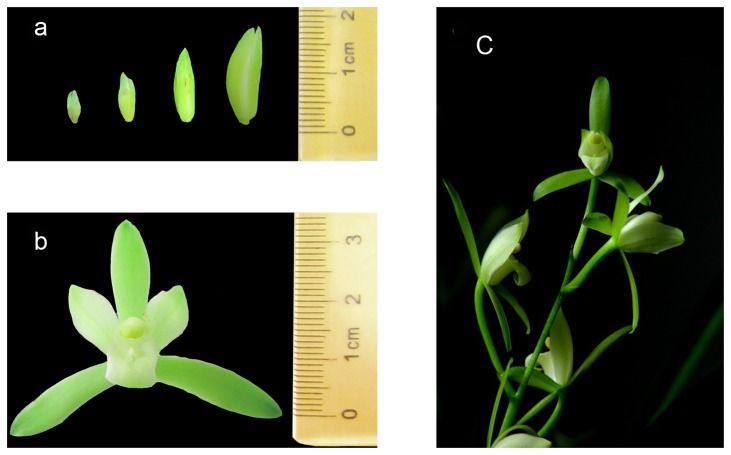
Four developmental stages of the flower bud and mature flower in C. ensifolium

a: Stage 1 <0.5 cm; Stage 2, 0.5 cm to 1.0 cm; Stage 3, 1.0 cm to 2.0 cm; Stage 4, 2.0 cm to 3.0 cm; b: mature flowers; c: inflorescence.